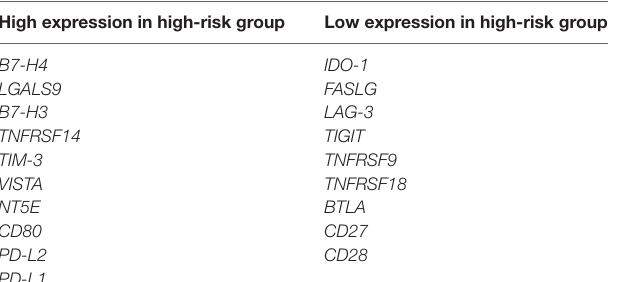
TaBle 1 | Risk assessment of high versus low-risk.